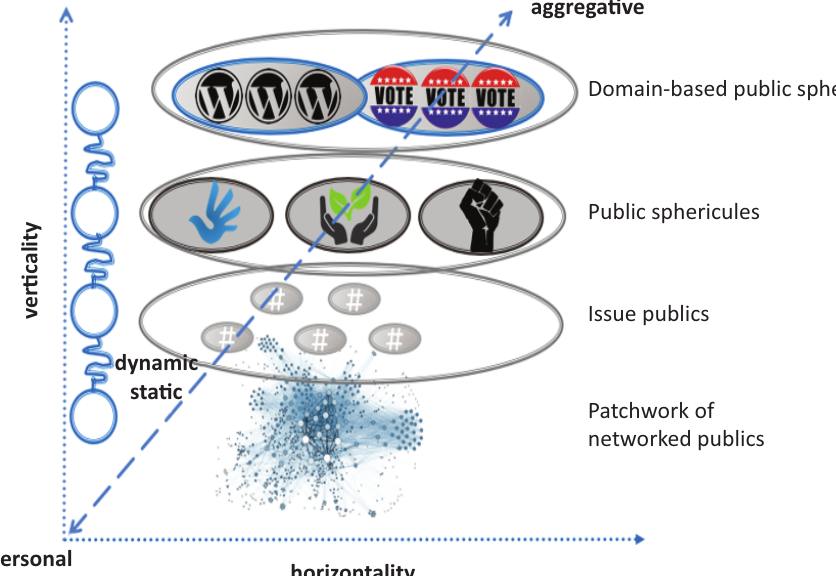
Figure 1. Dimensions of ‘interrelated public agendas’ and public spheres. Source: Authors composition. Media and Communication, 2020, Volume 8, Issue 4, Pages